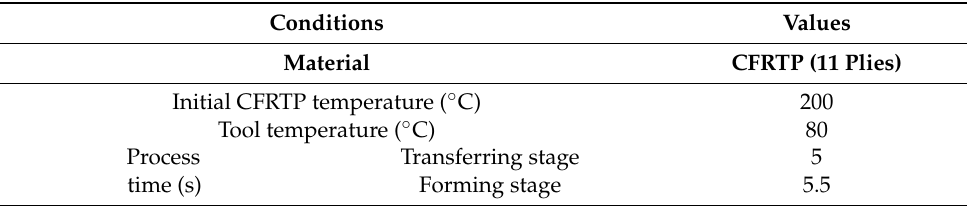
Figure 5. Determination of thickness and lay-up angle of CFRTP part: ( a ) FE model for structural analysis and ( b ) result of structural analysis for various thinness and optimized lay-up angles. Table 2. Conditions for FE simulation for forming process of CFRTP part.